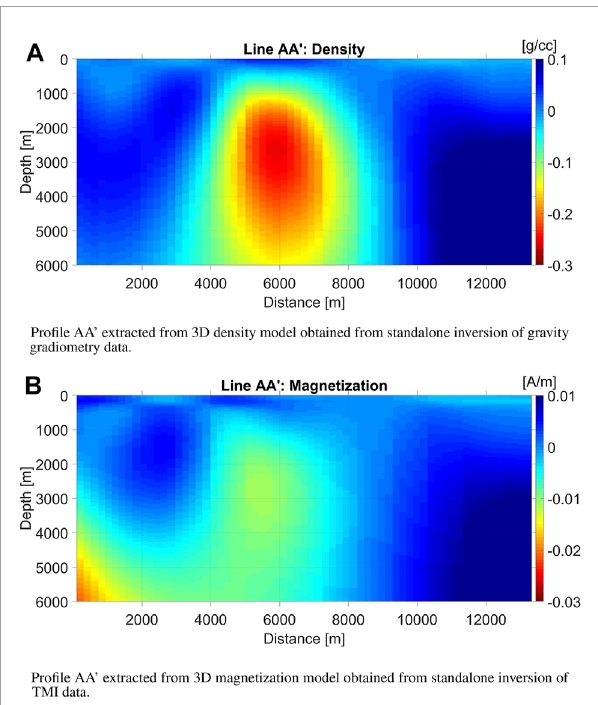
FIGURE 7 Deterministic Gramian inversion results. (A) Profile AA’ extracted from 3D density model obtained from deterministic Gramian inversion of the gravity gradiometry and TMI data. (B) Profile AA’ extracted from 3D magnetization model obtained from deterministic Gramian inversion of the gravity gradiometry and TMI